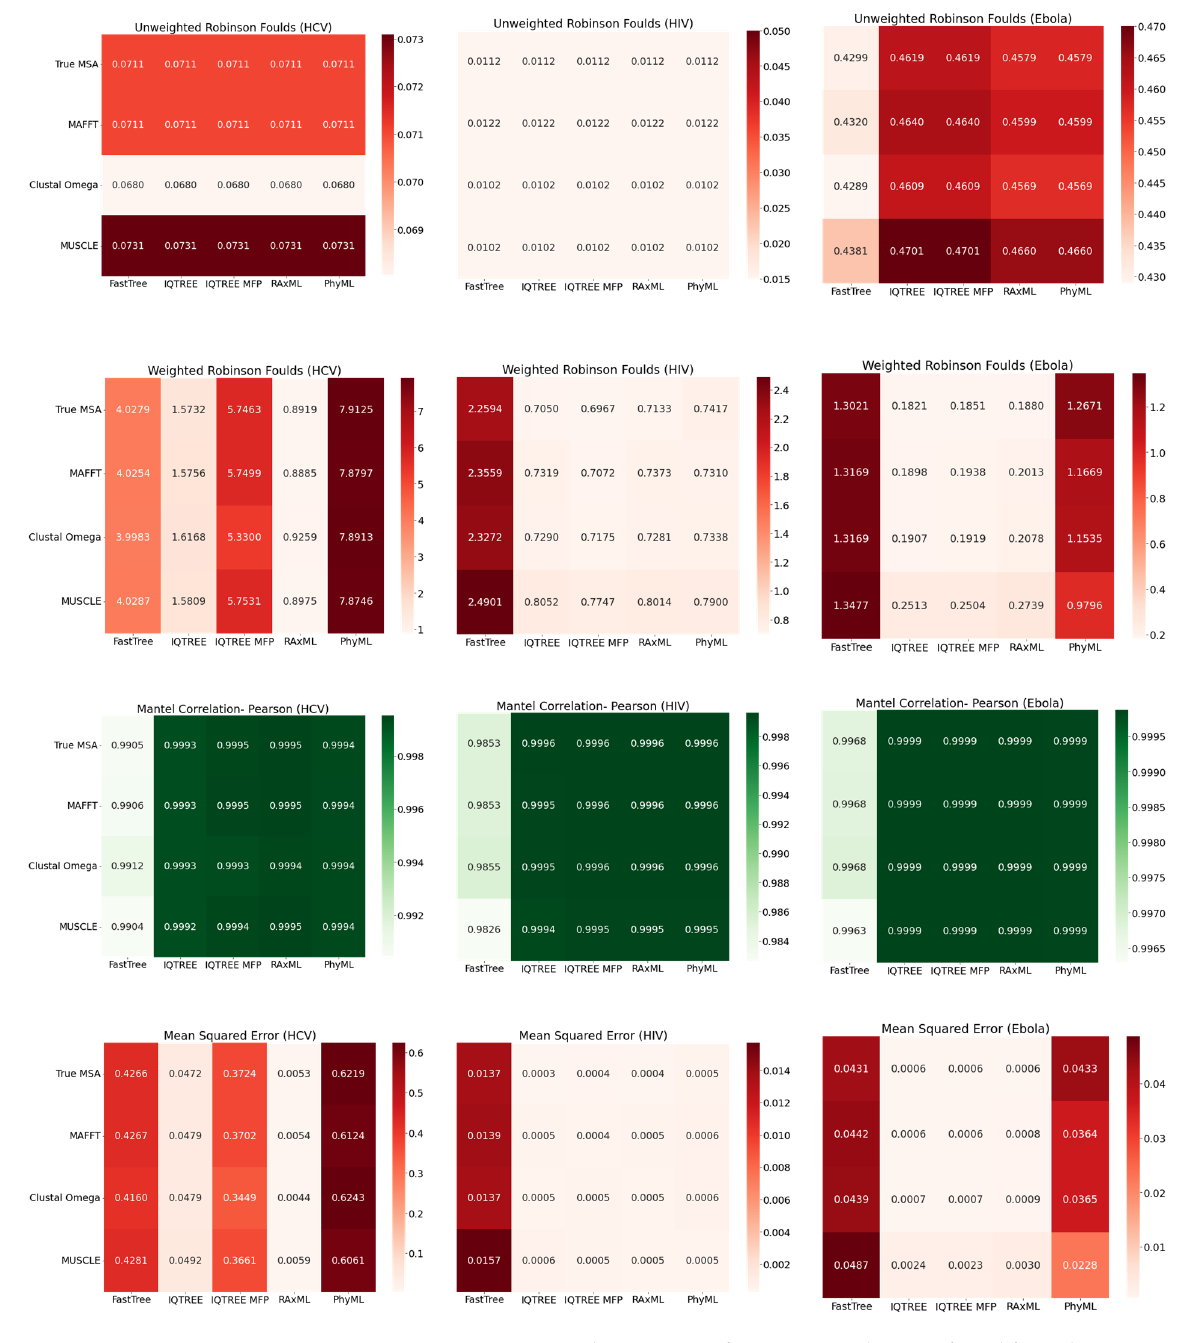
Figure 5. Heat maps comparing the accuracy of FastTree topologies inferred from the MAFFT, Clustal Omega, MUSCLE, and true multiple sequence alignments with branch lengths optimized by IQ-TREE (GTR), IQ-TREE (MFP), RAxML-NG, and PhyML. Each value of Unweighted Robinson–Foulds (URF), Weighted Robinson–Foulds (WRF), Pearson Mantel Correlation, and Mean Squared Error shown is the average of 10 simulation replicates. Heatmaps showing Spearman Mantel Correlation can be found in Supplementary Figure